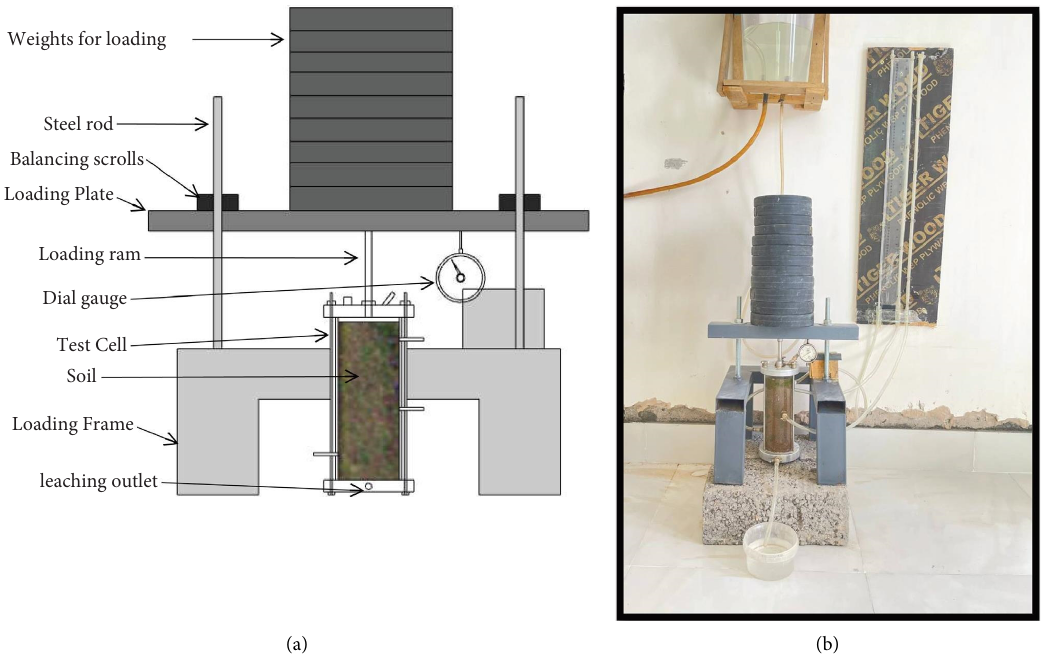
Figure 3: Engineering model of the leaching process: (a) schematic diagram and (b) apparatus for loading and leaching.